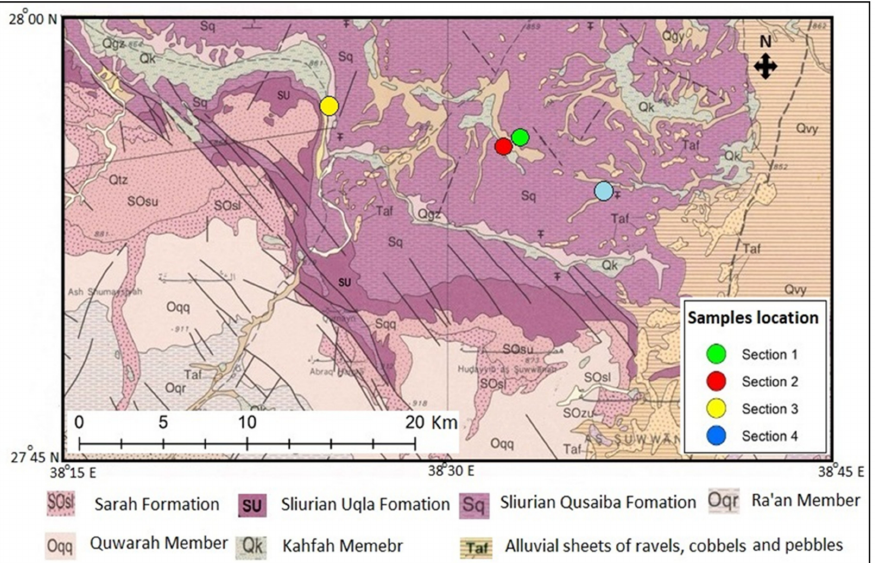
Figure 1. Location map of study area at Tayma quadrangle, northwestern Saudi Arabia. It shows different exposed geological rock units ranging in age from Paleozoic to Recent (Modified after